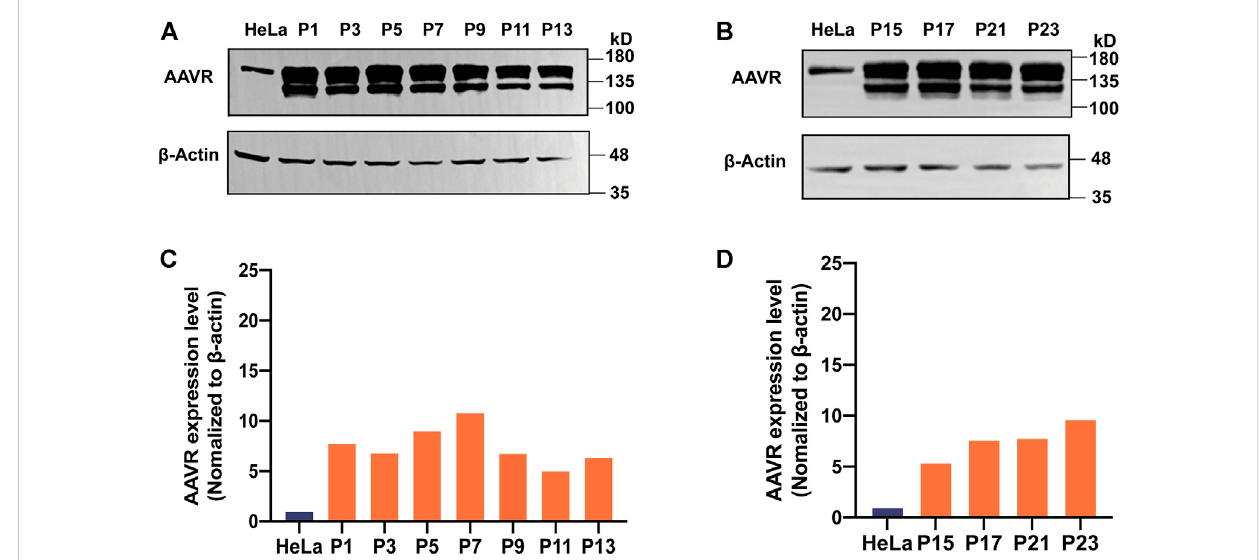
FIGURE 3 StabilityoftheoverexpressedAAVR intheAAVR-HeLacellline.Thestable cellswith overexpressedAAVR werepassagedfor 23generations,andthe AAVR expression level was analyzed by Western blotting. Cell samples were named according to their passages. (A) Western blotting analysis of AAVR expression levels inAAVR-HeLacells with thepassages ofP1, P3, P5,P7, P9, P11and P13. (B) Westernblotting analysisofAAVR expression levels in AAVR- HeLa cells with the passages of P15, P17, P21, and P23. (C) Fold change of AAVR protein expression levels of (A) . (D) Fold change of AAVR protein expression levels of (B) .